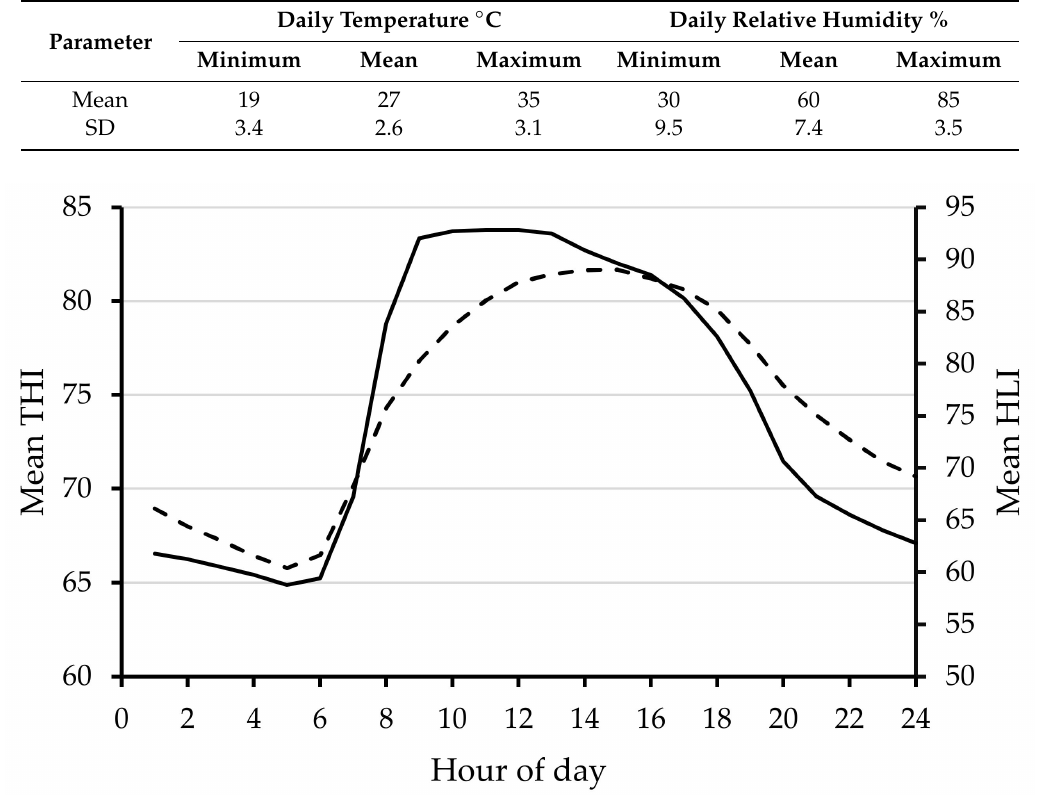
Table 5. Mean daily temperature and relative humidity with minimum and maximum values and SD for Experiment 2.